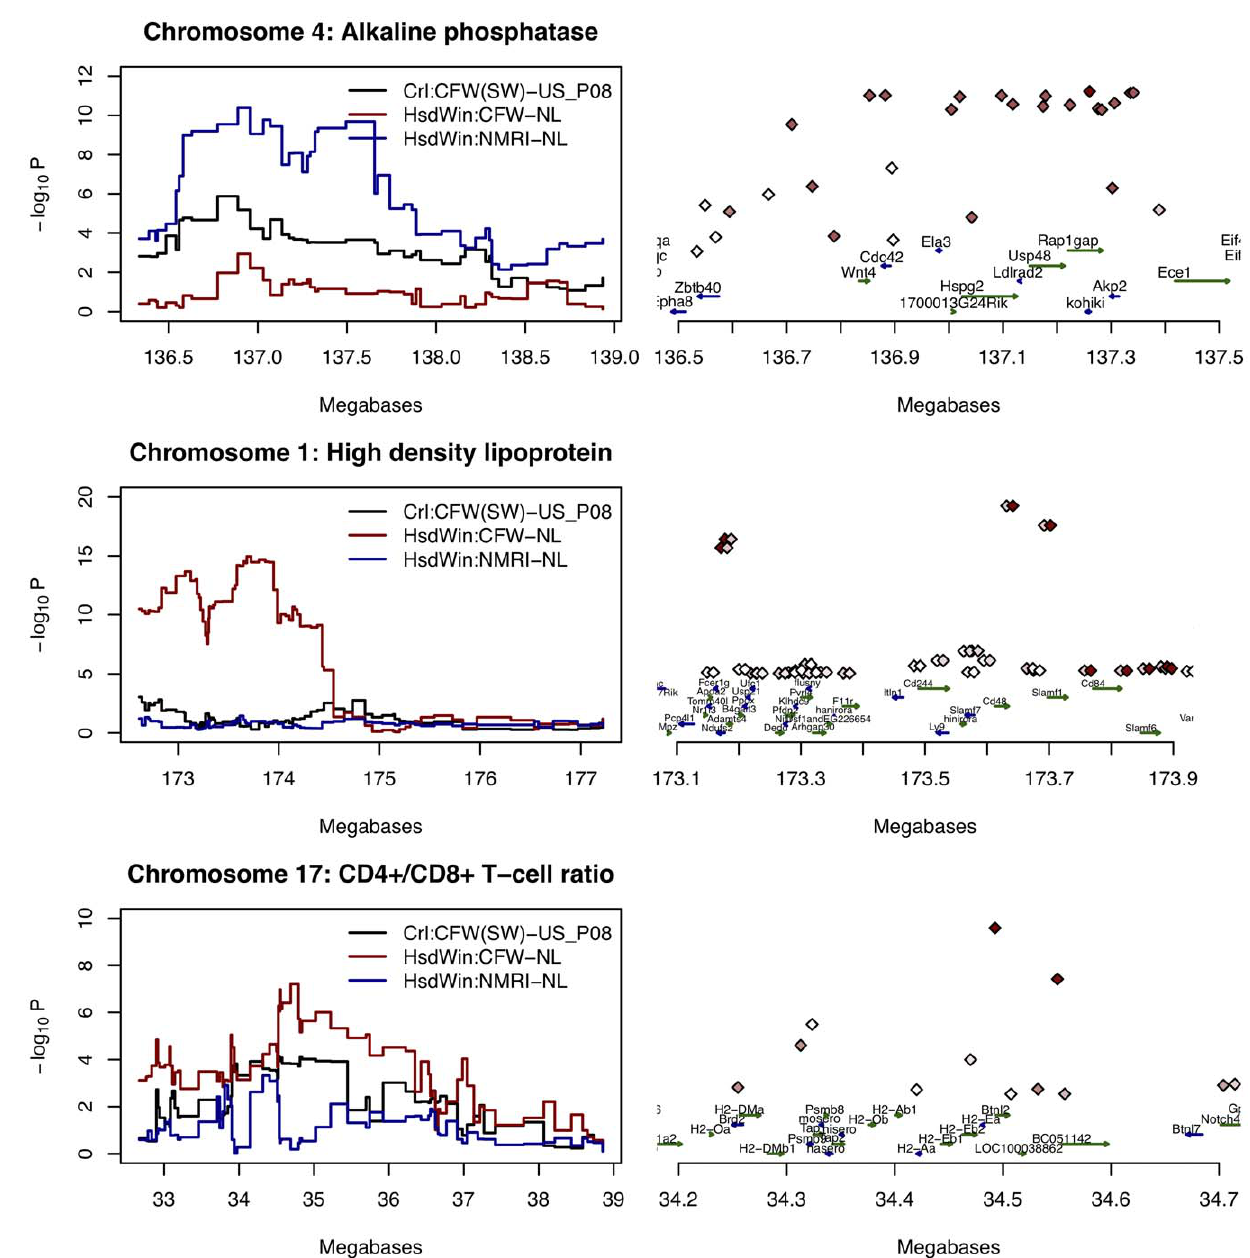
Figure 5. Association mapping of three phenotypes in three colonies. The vertical scale is the negative logarithm (base10) of the P-value for the association; the horizontal scale is the position in megabases on the chromosome. On the left of the figure are results for ancestral haplotype reconstruction analysis (HAPPY) for all three colonies; on the right single marker association is shown for one colony for each phenotype: HsdWin:NMRI-NL for alkaline phosphatase; HsdWin:CFW-NL for high density lipoprotein and Crl:CFW(SW)-US_P08 for the CD4 + /CD8 + T-cell ratio. LD structure around the associated SNP is shown by a red to white scale for r 2 =0 to 1. For high density lipoprotein, each marker is represented by two diamonds. The right hand diamond of each pair is colored to show the r 2 with rs3476237 (at 173.6 Mb and the left hand the r 2 with rs3709584 (at 173.1 Mb). Gene annotations are taken from the UCSC genome browser. Analysis of the ALP QTL revealed in all colonies a large region modeled the descent from the correct set of progenitors; second, of linkage disequilibrium extending from 136.7 to 137.3 Mb, in the absence of fine-scale recombination data, HAPPY consequently limiting mapping resolution. The region contains an mapping assumes a uniform genetic map, without hotspots, so alkaline phosphatase gene ( Akp2 ) at 137.3 Mb, but also an that the localization is relatively imprecise. We resorted therefore additional 9 genes. Mapping the QTL on chromosome 1 for to using single marker analysis and considering the LD structure HDL identified two peaks: rs13476237 at 173631526 and of each region to determine the most likely position of the QTL rs3709584 at 173177625 (Figure 5). In the colony showing (Figure 5).